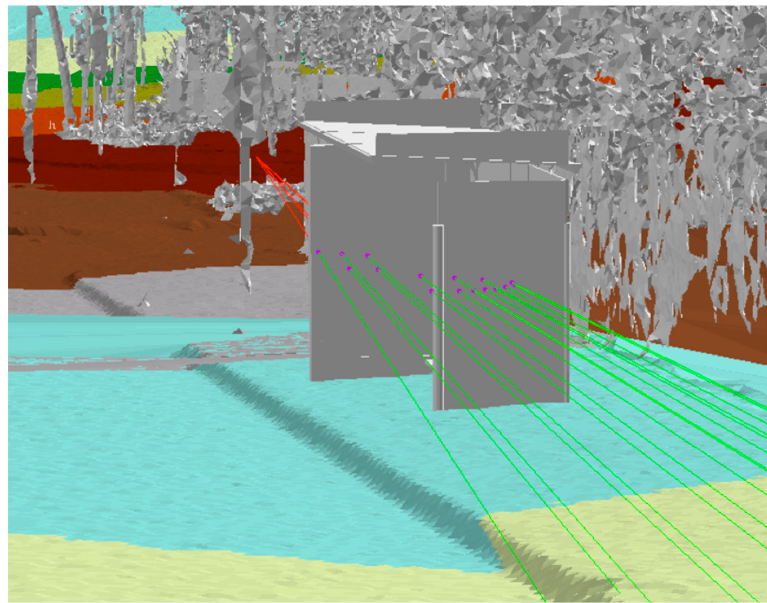
Figure 9. 3D view obstructed lines of